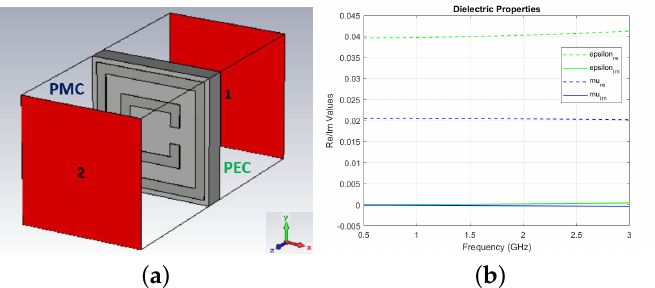
Figure 5. ( a ) Waveguide setup, with an incident wave propagating along Z-direction ( b ) Real and imaginary values of permittivity and permeability for the MTS.